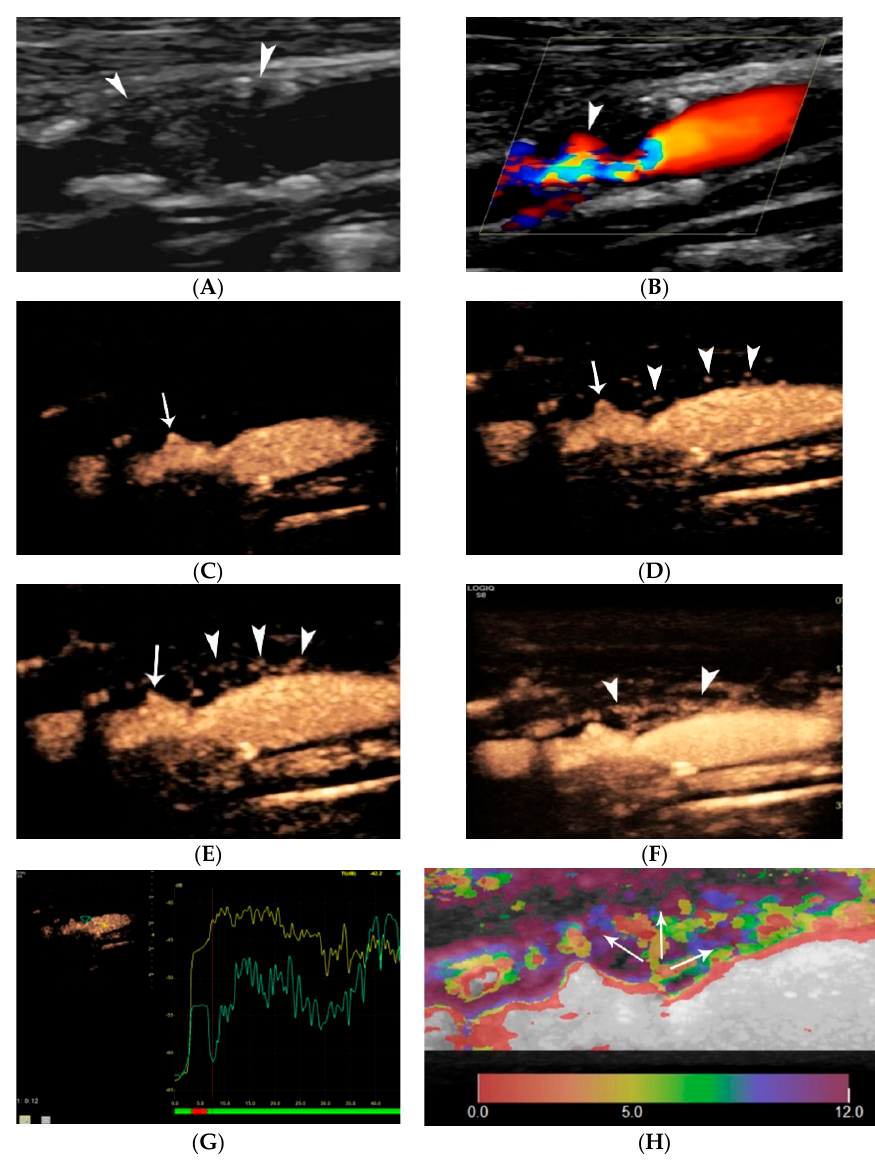
Figure 9. A 65-year-old man with stroke. B-mode US ( A ) shows an internal carotid plaque of mixed echogenicity causing severe stenosis. Colour-Doppler technique ( B ) shows blood flow turbulence confirming haemodynamically significant stenosis. Note the presence of a superficial ulceration (arrowhead). Consecutive CEUS images ( C – E ) confirm the presence of an ulceration (arrow), while microbubbles are progressively seen plaque core and adventitial layer, in keeping with severe intra- plaque neovascularization (arrowheads). Temporal Maximum Intensity Projection Image ( F ) showing all the microbubbles visualized within a specific time frame and thus creating a vascular map of intra-plaque neovascularization (arrowheads). Time-intensity Curve analysis ( G ) showing the enhancement of the plaque (green line) compared with the lumen (yellow line), providing quantitative data. Colour-coded parametric image ( H ) showing the flowing pattern and direction of microbub- bles inside the plaque core based on their time of arrival. A direction from lumen towards the adventitia can be appreciated.